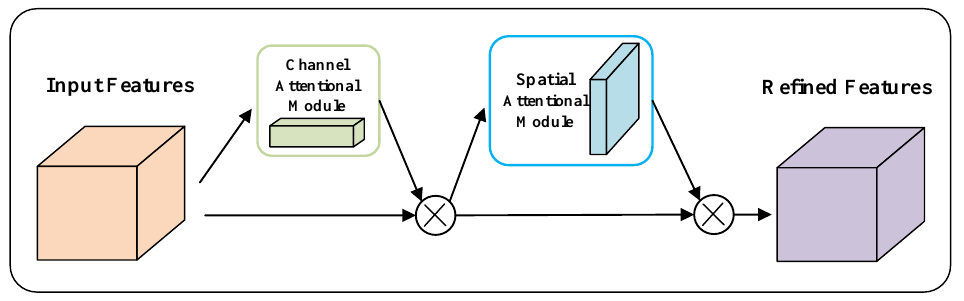
Figure 9. Convergence channel and spatial attention mechanism.